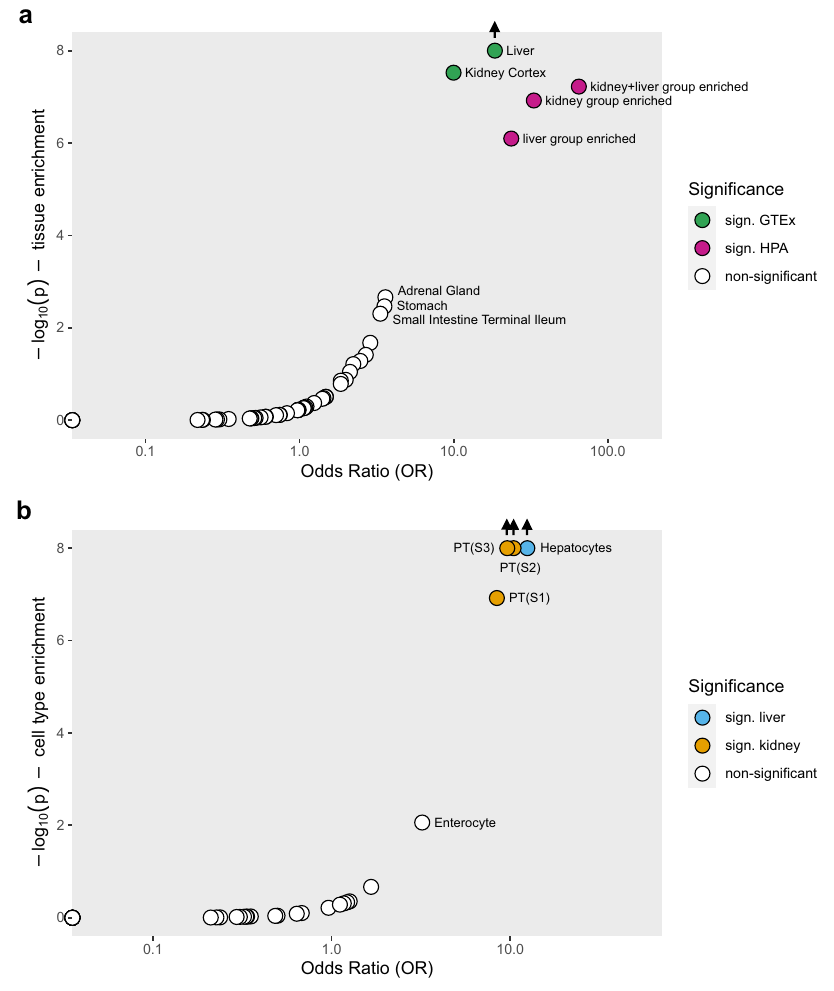
Fig. 6 Enrichment analysis of the 30 signi fi cantly associated genes in human tissues and cell types. Enrichment analyses were performed across 39 human tissues represented in GTEx Project V8, and in liver, kidney and both liver and kidney from the Human Protein Atlas (HPA) ( a ); and across cell types from kidney, liver and gut based on single-cell RNA-sequencing data ( b ). Source data are provided as a Source Data fi